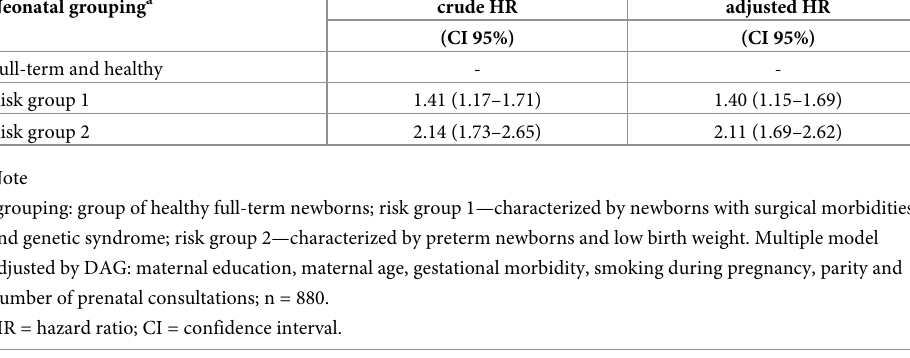
Table 3. Single and multi-covariate Cox regression models of exclusive breastfeeding discontinuation by risk neo- natal profile in a referral center for high-risk infants, Rio de Janeiro, RJ, Brazil, 2018. Neonatal grouping